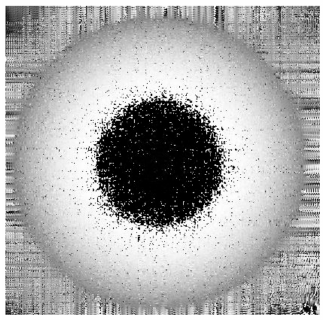
Figure 10. Digital interferogram of the object light field at t2 moment.